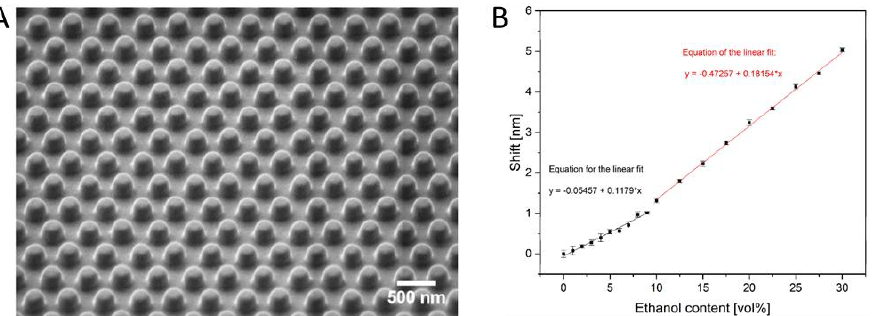
Figure 13. ( A ) Scanning electron microscope image (SEM) of the nanostructured gold sensor substrate. ( B ) Shift of the resonance wavelength with increasing ethanol content due to the deswelling of the PAM hydrogel showing the linear behaviour of the refractive index change. (Reprinted from [152]).